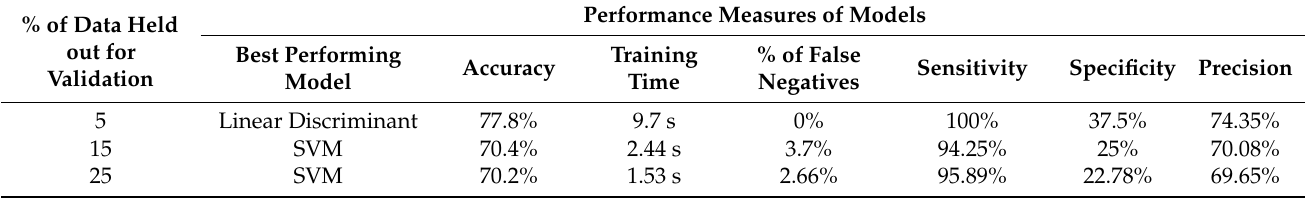
Table 2. Results obtained using holdout